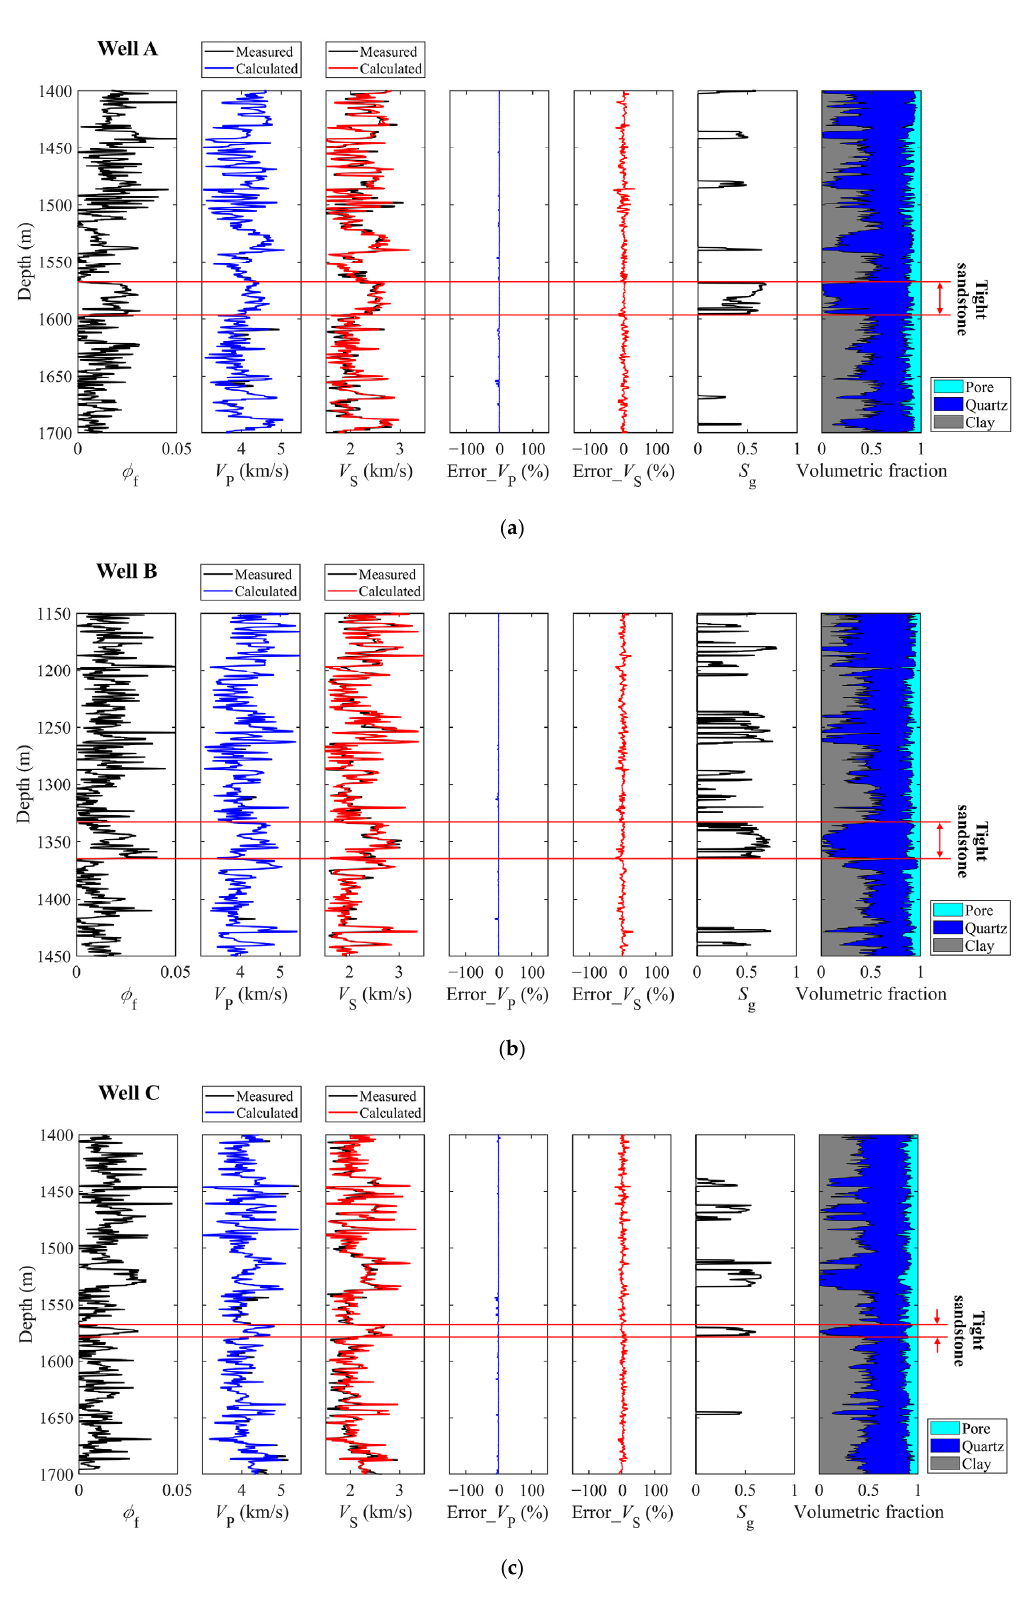
Figure 6. Model-based prediction results for ( a ) well A, ( b ) well B, and ( c ) well C. The curves include ϕ f , V P , V S , relative errors in V P and vs. estimations, S g , and volumetric fractions of compositions.